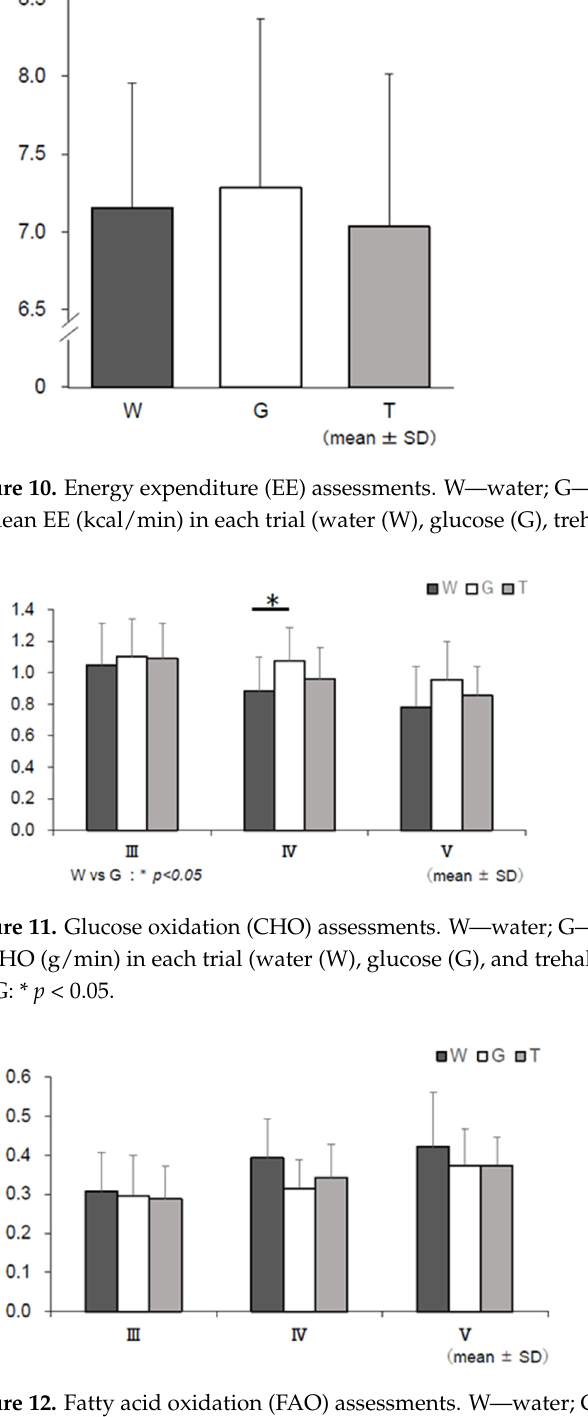
Figure 9. Respiratory exchange ratio ( RER) assessments. W—water; G—glucose; T—trehalose.